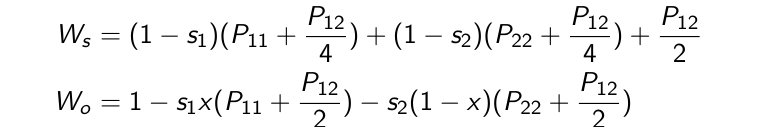
Figure A2 – Representing the combinations of s 1 and s 2 (assuming s 1 > s 2 ) for which the inequality presented in Equation 1 from the main text is true (the regions above and to the right of the lines) for different values of σ ( 0 , 0.5 , 0.95 and 1 , in blue, orange, green and red, respectively). The dotted lines represent the coefficients of selection based on the number of loci carrying mutations with a coefficient of selection s = 0.01 and dominance h = 0.2 (see Eq. 3 in the main